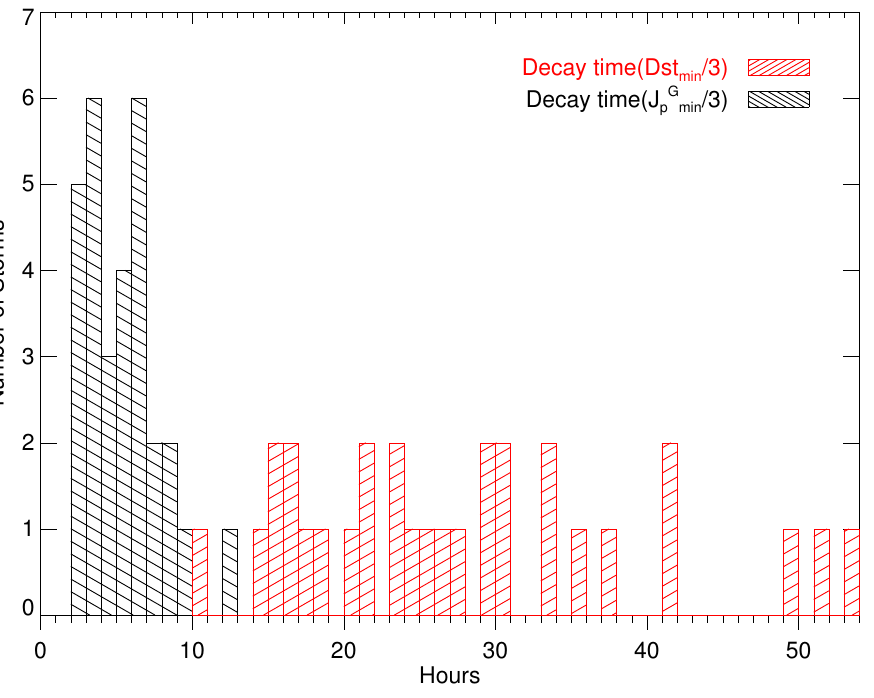
Figure 10. Distributions of magnetic storm recovery durations, the start and end time of the recovery phase are the time when the geomagnetic index is at the minimum value and the time when the geomagnetic index is restored to 1/3 of the minimum value, the red is the Dst index, and the green is the J G p